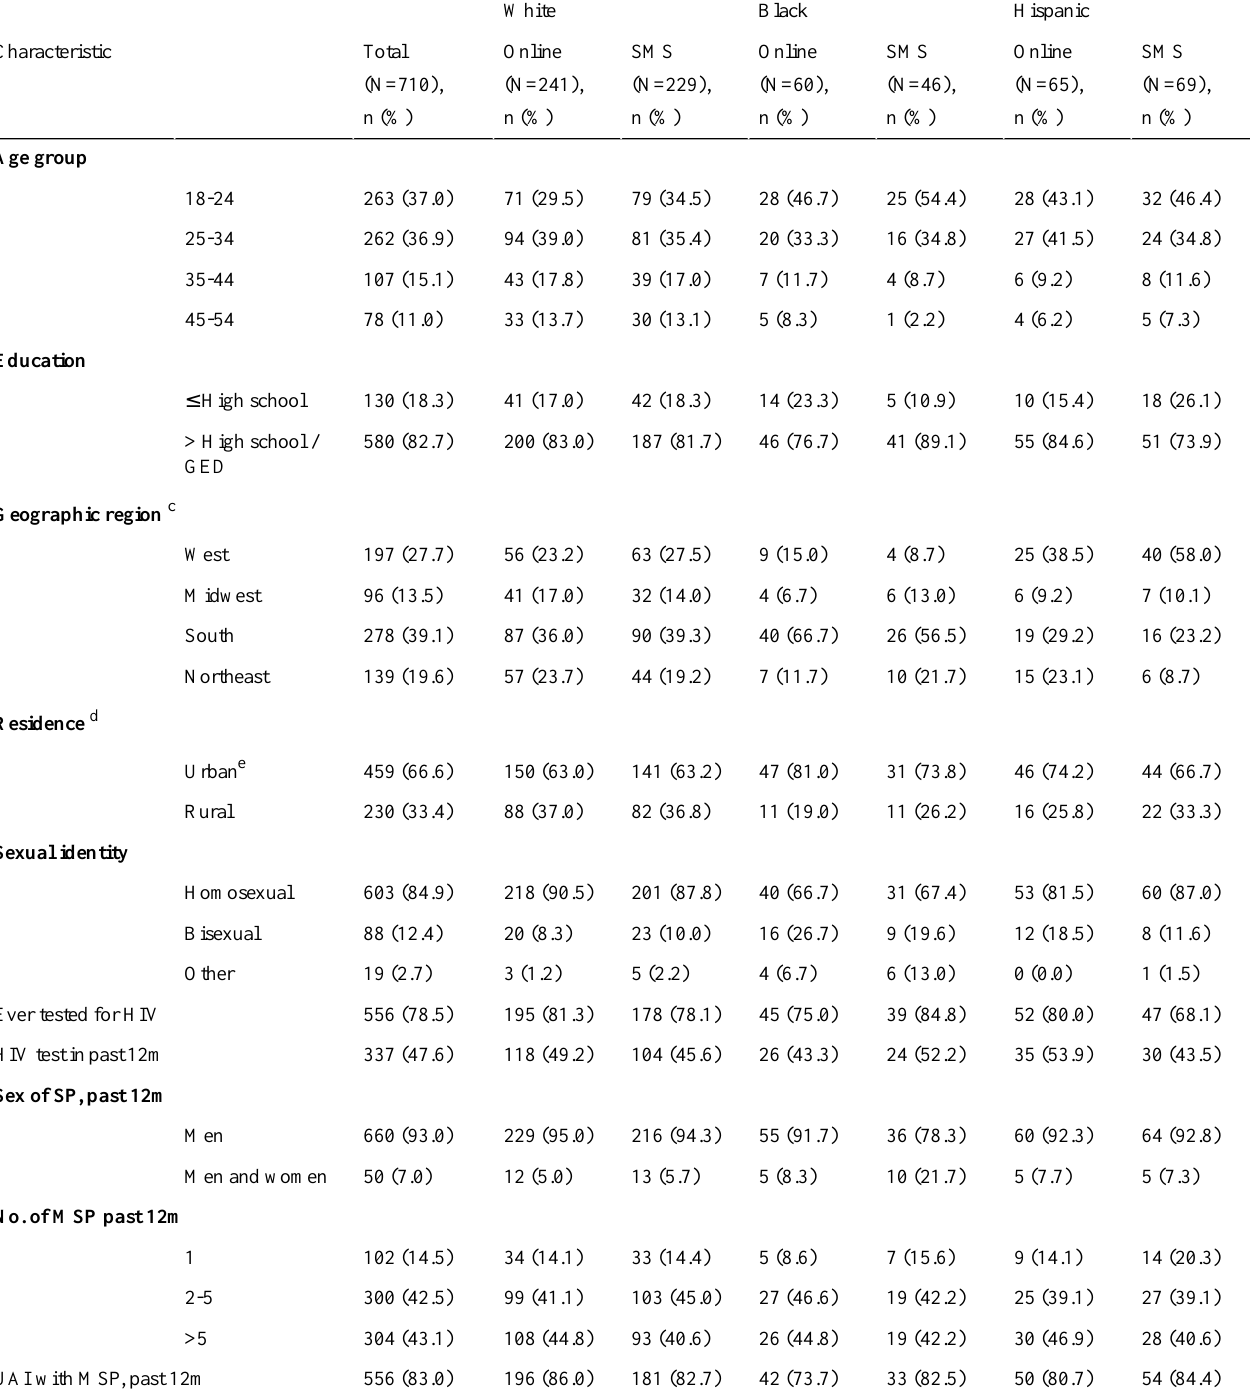
Table 1. Baseline characteristics of participants in an online study, by race/ethnicity and randomization arm (N=710). a, b